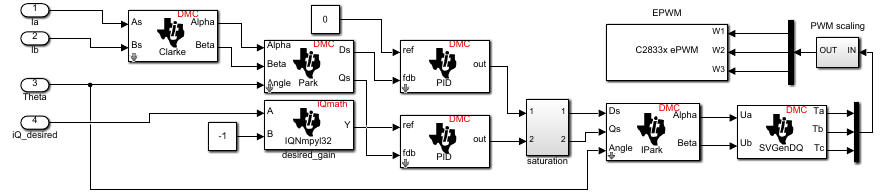
Figure 7. DSP automatic code generation model for FOC system.